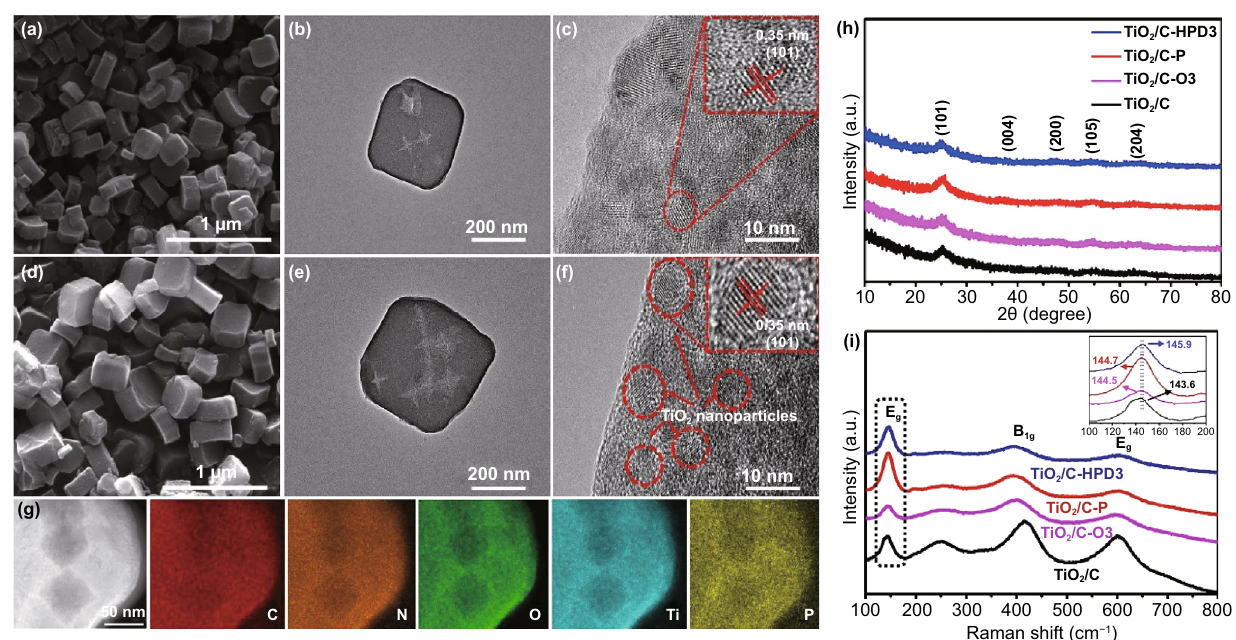
Fig. 2 a – c SEM, TEM and HRTEM images of the TiO 2 /C-O3. d – f SEM, TEM and HRTEM images of the TiO 2 /C-HPD3. g HAADF-STEM image of the TiO 2 /C-HPD3 and the elemental distribution of C, N, O, Ti, and P. h XRD pattern and i Raman spectra of the TiO 2 /C, TiO 2 /C-P, TiO 2 /C-O3 and TiO 2